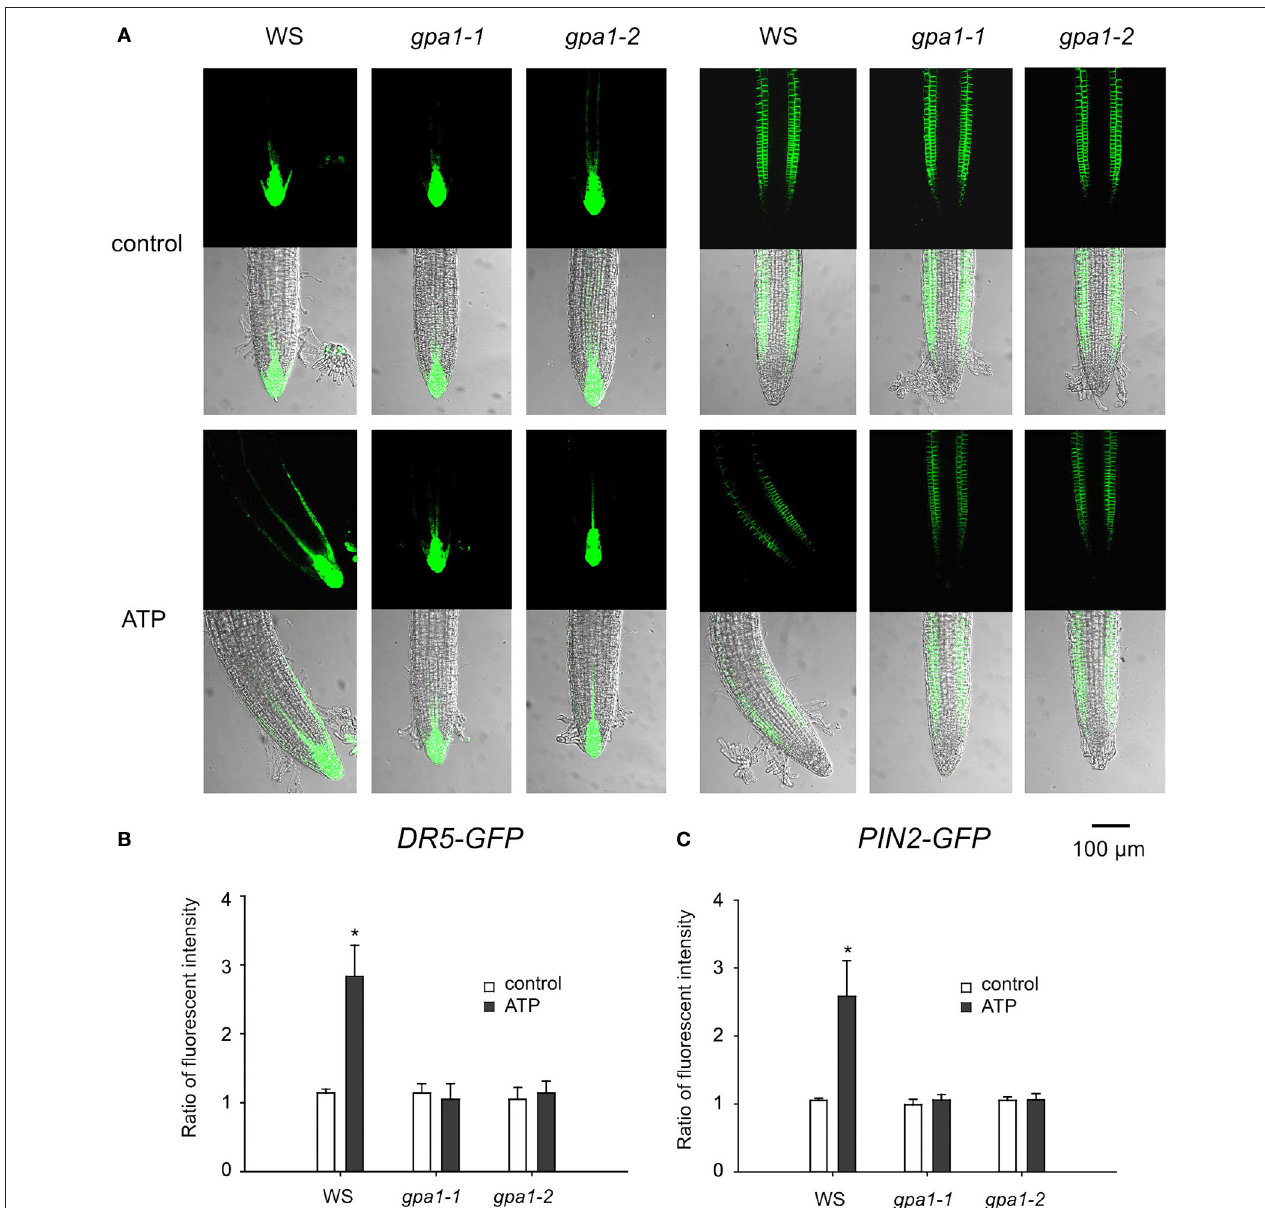
FIGURE 8 | Heterotrimeric G α is involved in eATP-induced asymmetric distribution of DR5-GFP and PIN2-GFP. DR5-GFP or PIN2-GFP transgenic WS, gpa1-1 and gpa1-2 seedlings were grown in 1/2 MS medium for 4 days and then transplanted onto 0.5 mM ATP-containing jointed medium. After 24 h, fluorescence was detected by using CLSM. (A) Fluorescence in representative root tip cells. The scale bar is showed below. (B,C) note fluorescence intensity ratio (fluorescence intensity in right-side cells relative to that in left-side cells) of DR5-GFP (B) and PIN2-GFP (C) , respectively. In each experiment, fluorescence intensity in up to 10 roots was measured. Data from 3 replicates were calculated to get the mean ± SD. Student’s t -test p -values: * p <